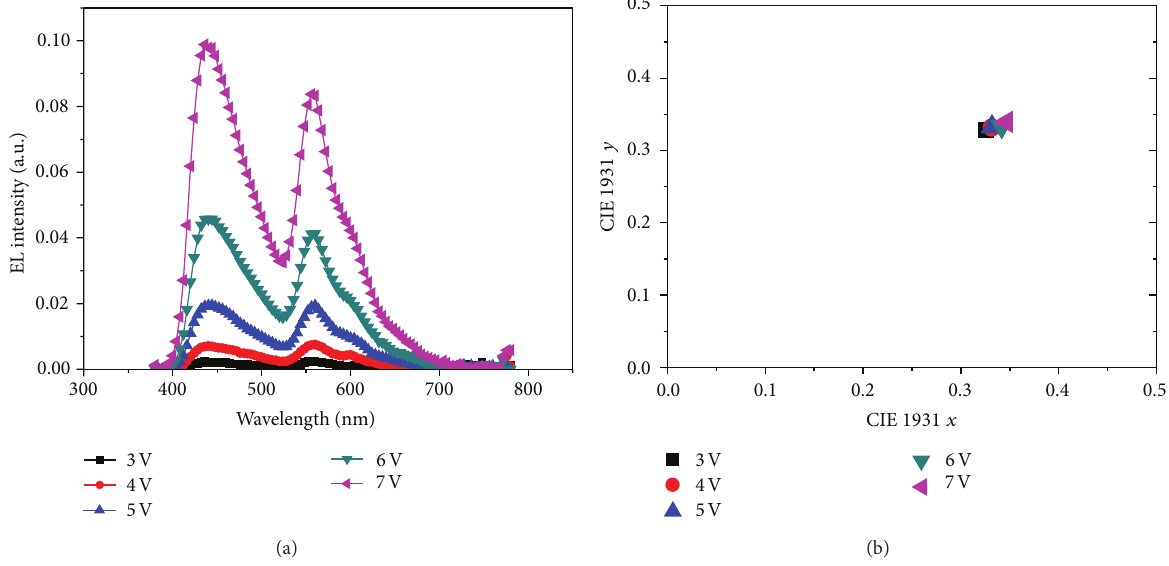
Figure 7: (a) The EL spectra of device C at 3 ∼ 7V applied voltage. (b) The CIE coordinates of device C at 3 ∼ 7V applied voltage.